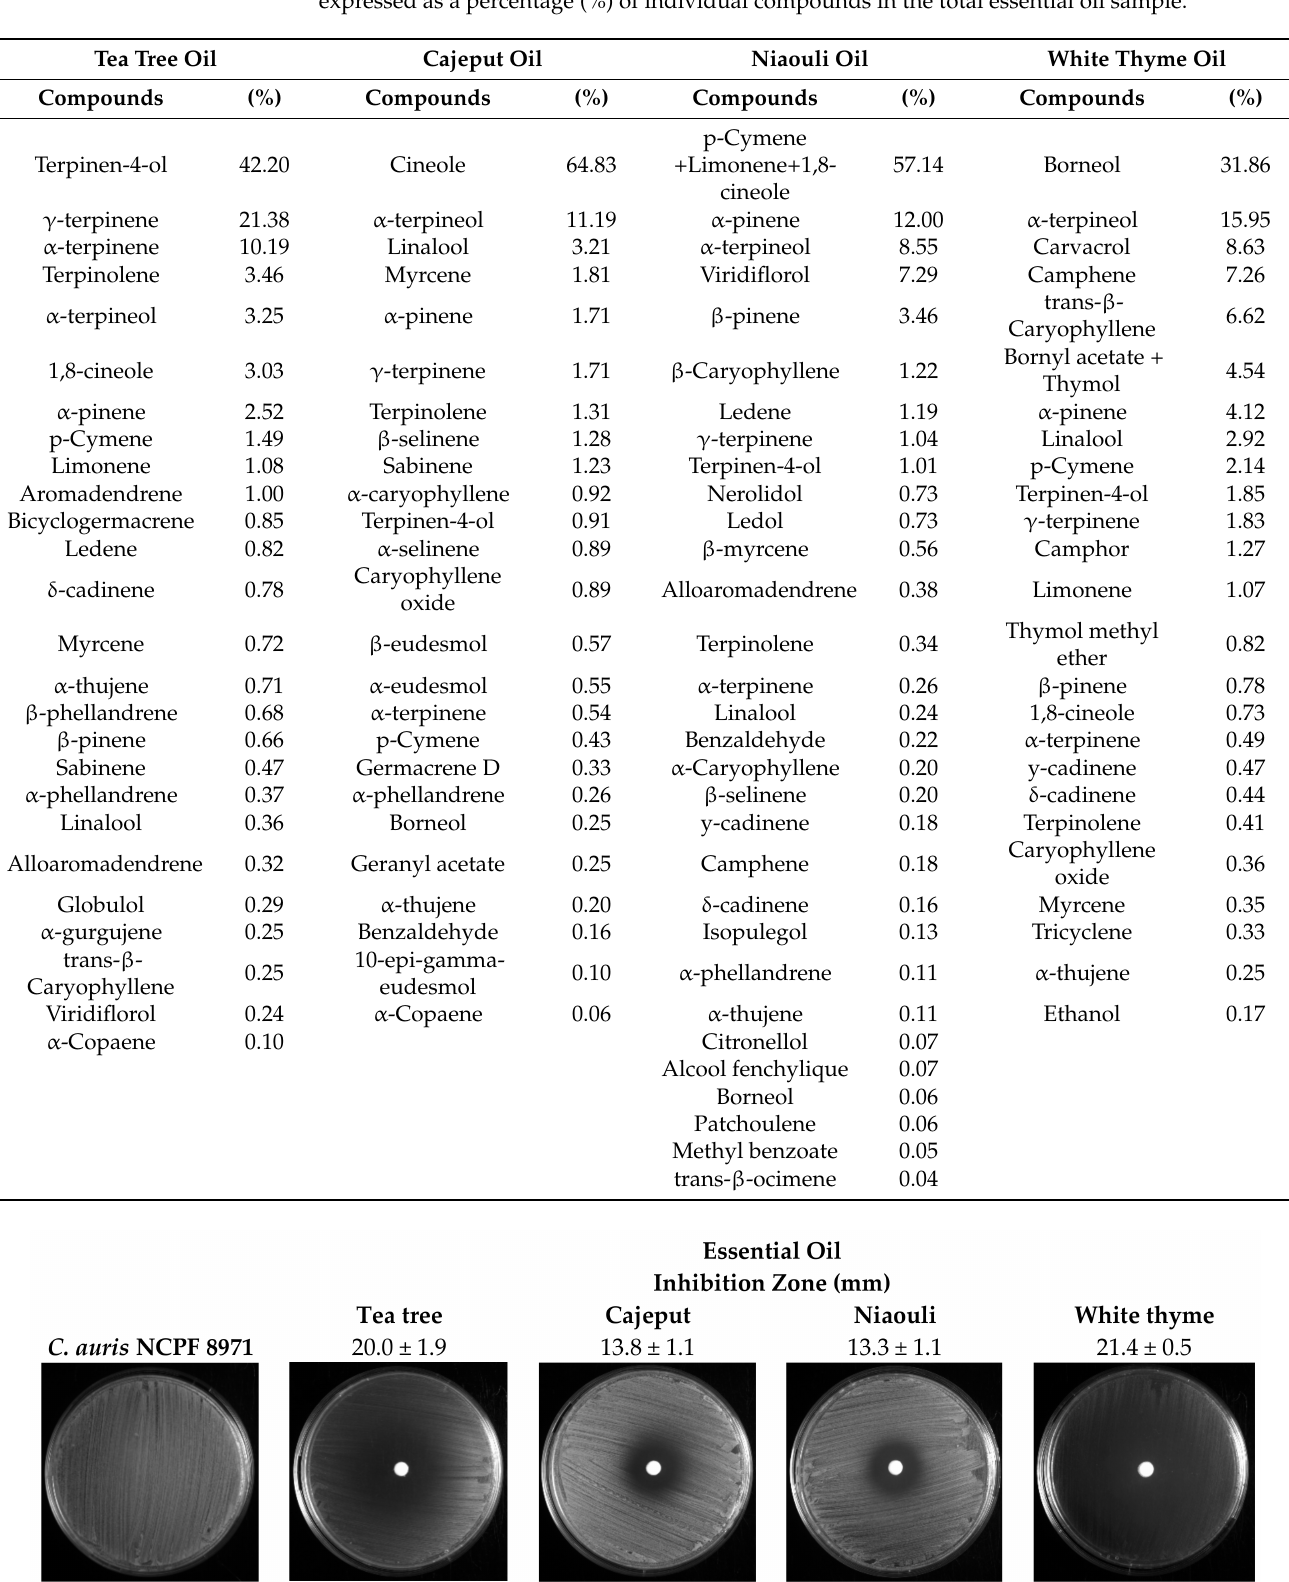
Table 1. Identification of the components of tea tree, cajeput, niaouli and white thyme essential oils expressed as a percentage (%) of individual compounds in the total essential oil sample.